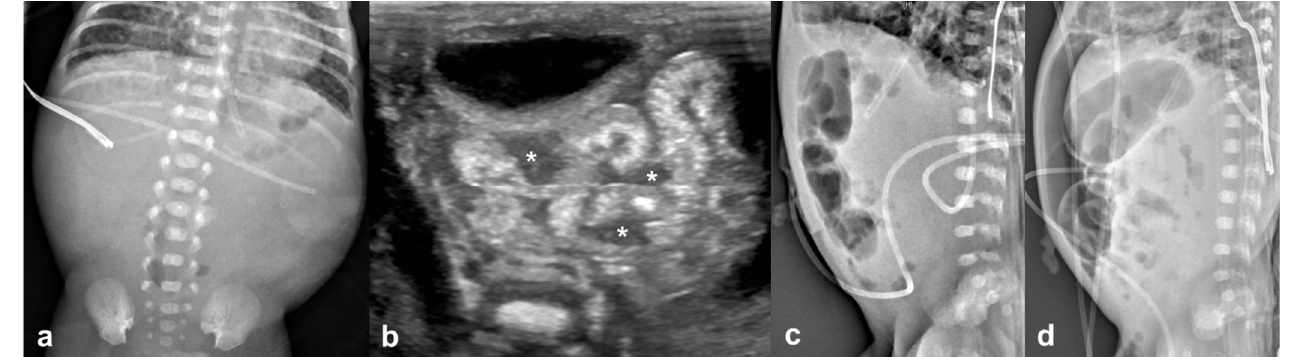
Figure 3. 21-day-old boy (born at gestational age of 23 weeks and 2 days) with perforated necrotizing